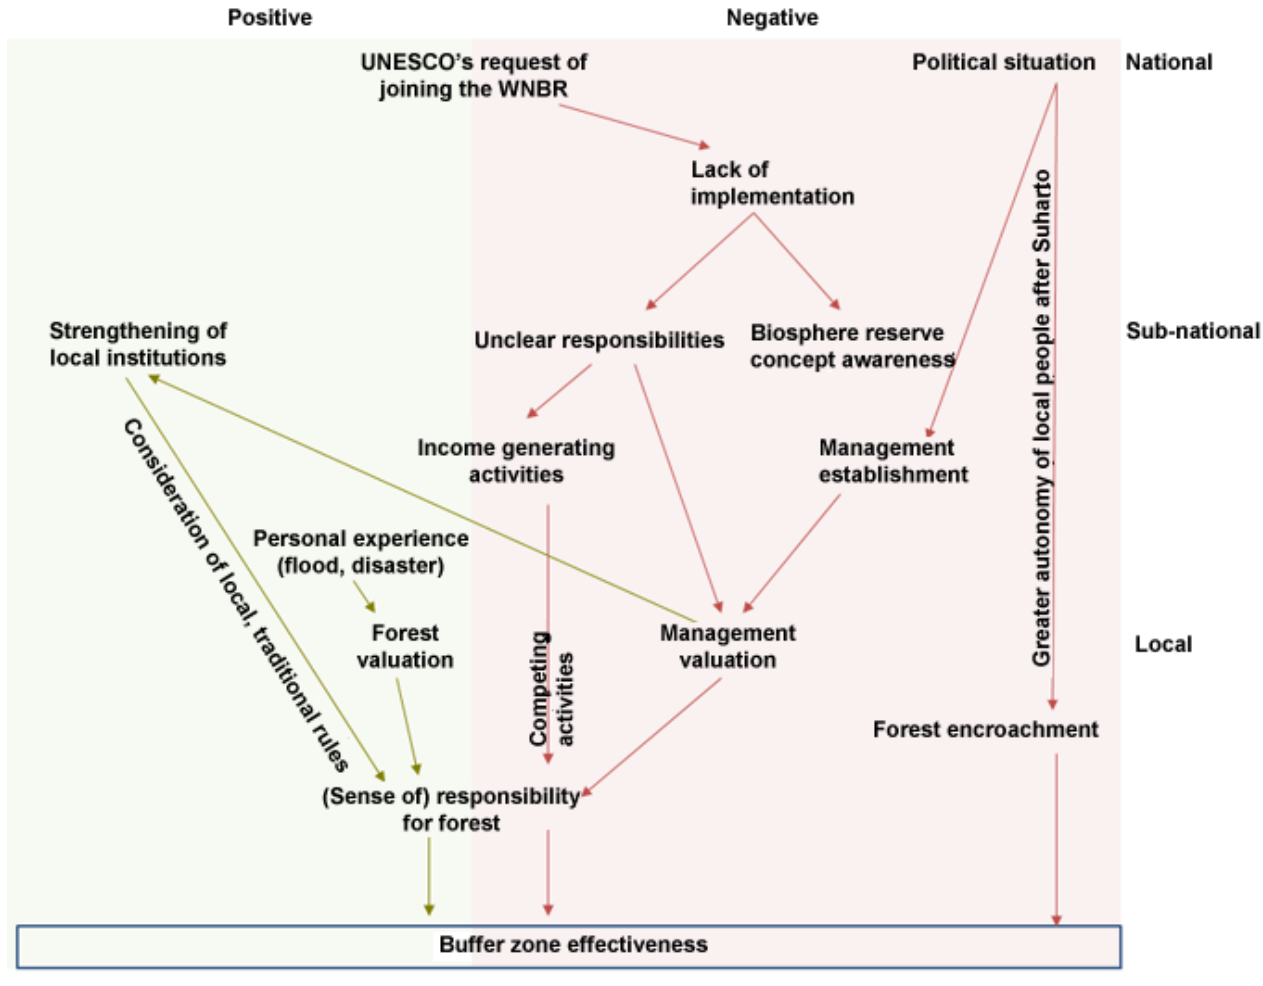
Fig. 5 . Institutional drivers at national, sub-national, and local level impacting buffer zone management in Lore Lindu Biosphere Reserve. Red arrows indicate negative influence and green arrows depict positive